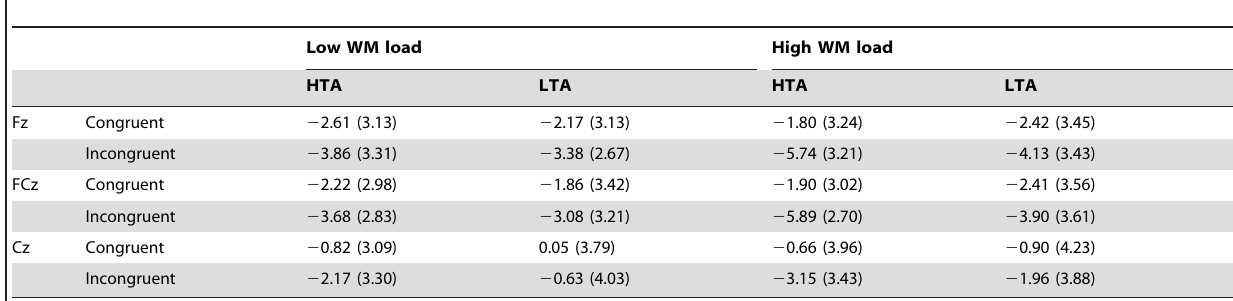
Table 3. N2 amplitudes ( m V) in the flanker task as a function of conditions for the high-trait-anxious (HTA) and low-trait-anxious (LTA) groups (Mean 6 Standard